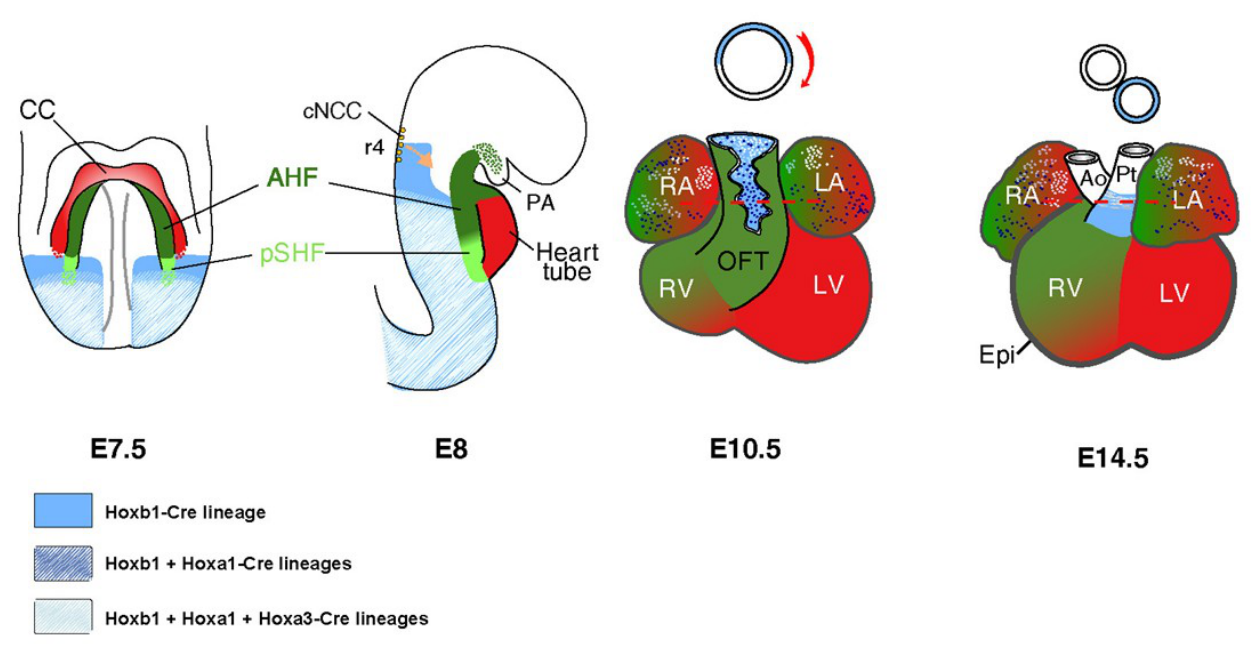
Figure 1. Cardiac contribution of progenitor cells expressing Hox genes in the second heart field. Diagram showing stages of heart development and contribution of the first heart field (red) and second heart field (green) to the heart. Frontal view is shown for embryonic day 7.5 (E7.5), E10.5, E14.5 and lateral view for E8. As second heart field (SHF) progenitor cells are added to the elongating heart tube, they contribute to formation of the right ventricle, outflow tract (OFT) and both atria. The left ventricle is derived exclusively from the first heart field (FHF), which also contributes to atria formation. In the early embryo (E7.5–E8), Hoxa1/b1/a3 expressing cells characterize distinct subdomains along the anterior-posterior axis of the SHF. At later stages, Hoxa1/b1/a3 progeny contribute to both atria and the inferior wall of the OFT (E10.5), which subsequently gives rise to the subpulmonary myocardium (E14.5). AHF, anterior heart field; Ao, aorta; CC, cardiac crescent; cNCC, cardiac neural crest cells; Epi, epicardium; LA, left atrium; LV, left ventricle; PA, pharyngeal arch; Pt, pulmonary trunk; RA, right atrium; RV, right ventricle; pSHF, posterior second heart